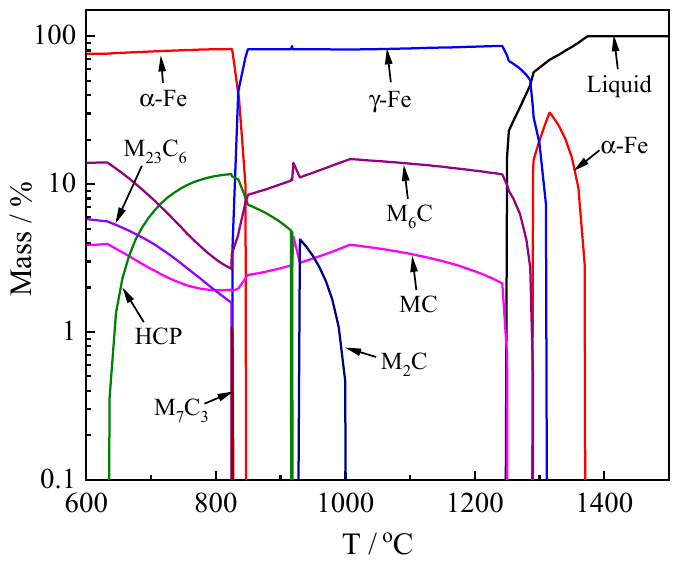
Figure 7. The phase equilibrium and transformation during solidification of liquid steel. Table 3. Transformation temperature of precipitates in steel, calculated by Thermo-Calc. Ts/°C